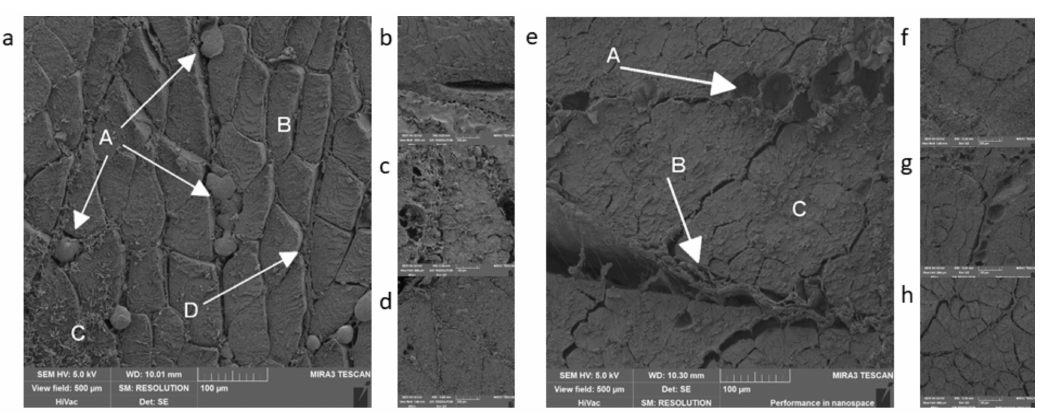
Heat-treated meat products: ( a , b )—Orava bacon, procedure 1, A —fat droplets, B —muscle fibers, C —artifacts, D —connective tissue- endomysium; ( c , d )—English bacon, procedure